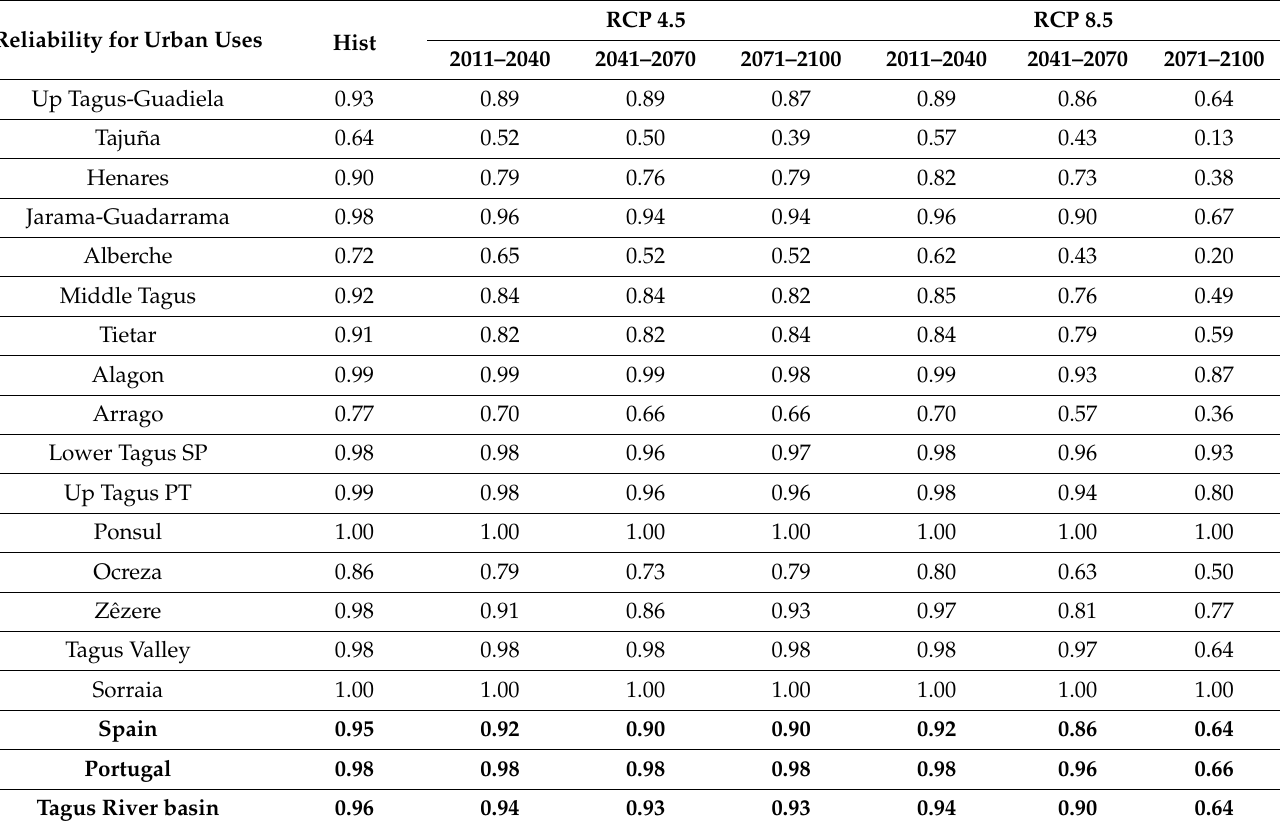
Table 1. Reliability of urban supply under future